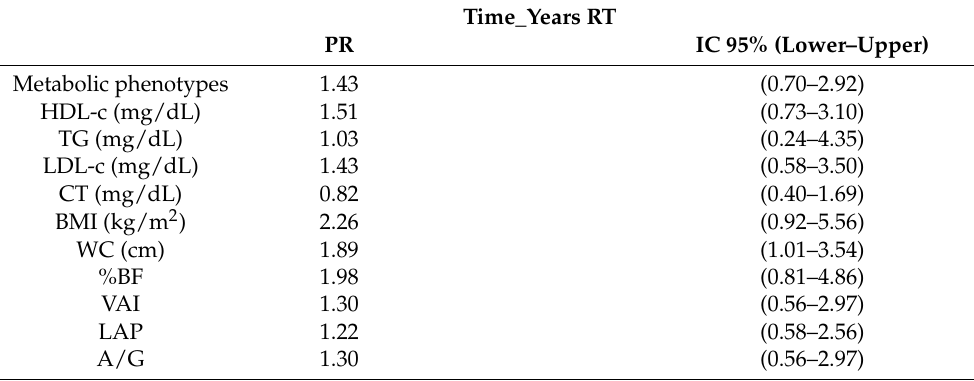
Table 5. Prevalence ratio between body variables, lipid profile and metabolic phenotypes and time in years, in minutes per week per and weekly frequency of